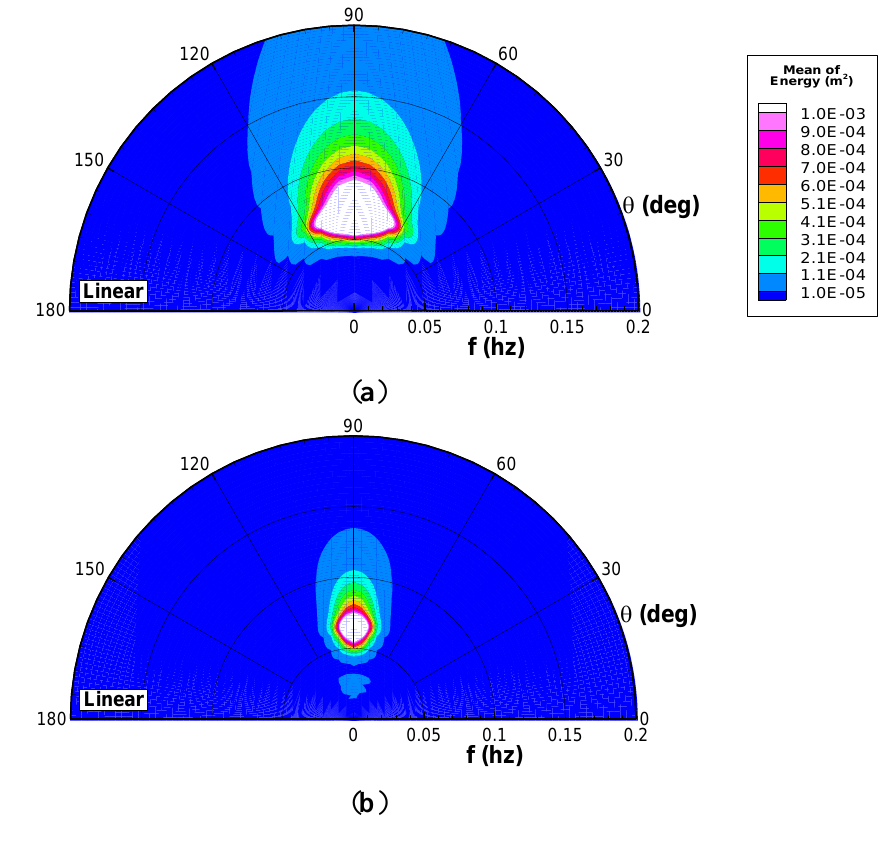
Figure 6. Evolution of the directional shore-perpendicular JONSWAP spectrum (see Table 1). ( a ) Initial spectrum in 15 m water depth; ( b ) Linear evolution (3 m water depth); ( c ) Nonlinear evolution (3 m water depth). Simulations are averages over N = 100 random phase